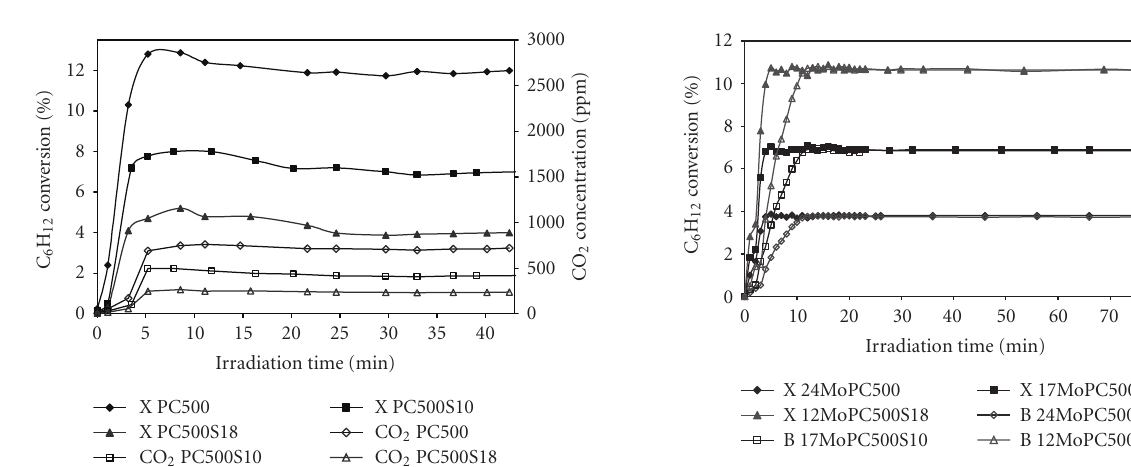
Figure 7: Cyclohexane conversion (X) and benzene outlet concen- tration (B) on 24MoPC500, 17MoPC500S10, and 12MoPC500S18 as a function of irradiation